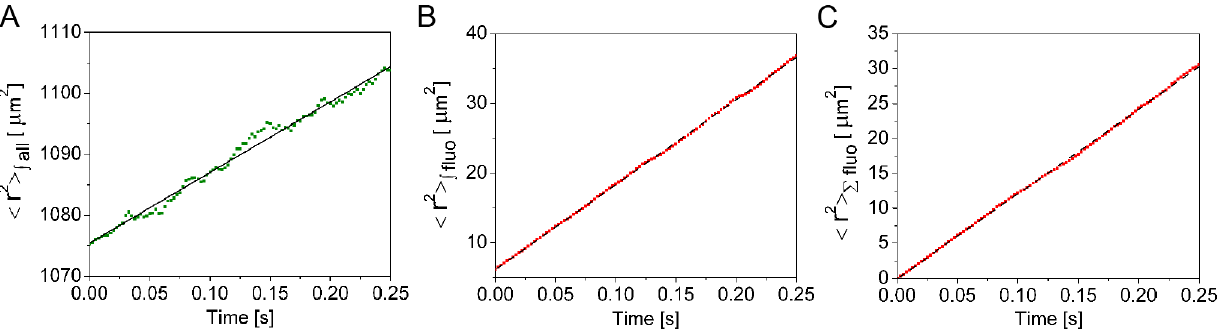
Figure 1. Second moments of particle distributions and mean square displacements obtained from a simulation of freely diffusing particles. The data for this figure (shown in green and red) comes from the simulation of Video 0.1 which corresponds to a system of particles that diffuse with D f ~ 20 m m 2 = s in the absence of binding sites. The simulation starts with an equilibrium situation that is perturbed by adding N ~ 1875 fluorescent particles to the the central (5 m m ) 3 cube of the (20 m m ) 3 simulation volume. In this figure we characterize the rate at which the deviations with respect to equilibrium of the concentrations of all particles and of the added ones spread out with time by means of second moments. We compare these second moments with the MSD of the added particles. Please notice that we are not plotting the mean square displacements in A ) and B ) but a quantity (the second moment) that depends linearly with the time lag with the same slope as the mean square displacement. For more (shown in green) computed using Eq. (12) with n i the number of all particles in the i th box. Linear fit details see Materials and Methods. A : S r 2 T Ð all (shown in black). B : S r 2 T Ð (shown in red) computed using Eq. (12) with n i the number of fluorescent particles in the i th box. Linear fit (shown in fluo black). C : The mean of the squared displacements of the added particles (shown in red) computed using Eq. (11). Linear fit (shown in black). As explained in supplementary text S3 the diffusion coefficient, D , can be estimated by taking 1/6 of the slope of the fitting curves. In this case the three